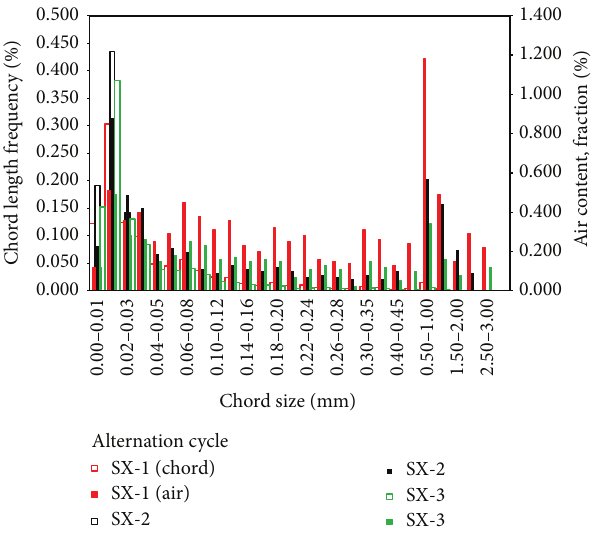
Figure 5: Bubbles distribution law curves of samples under four times’ alternation of sodium sulfate erosion.